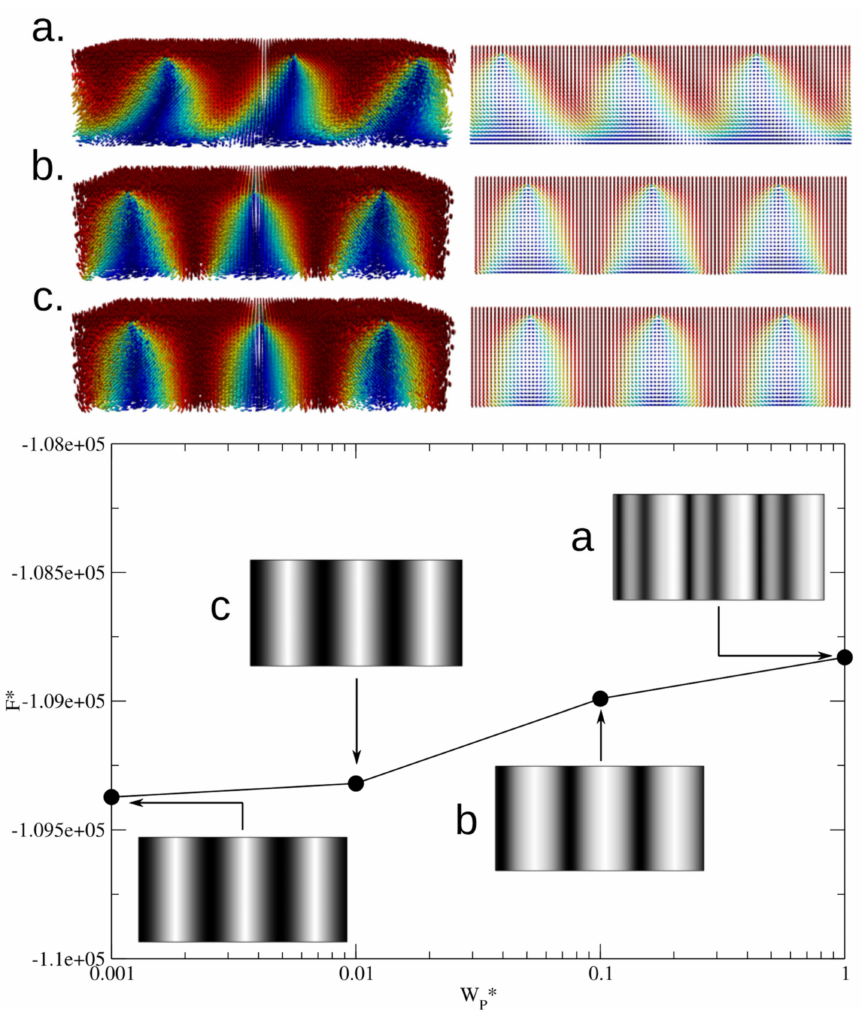
Figure 6. Simulations of a CLC confined in a hybrid channel. The top homeotropic anchoring is kept as W * H = 1.0. (Top) Images of the obtained configurations at different anchoring energies and the corresponding 2D lateral projections, ( a ) strong planar anchoring at bottom surfaces, ( b ) moderate planar anchoring and ( c ) weak planar anchoring. Colormap as in Figure 5. (Bottom) Free energy as a function of the anchoring energy, the insets correspond to cross-polarizer